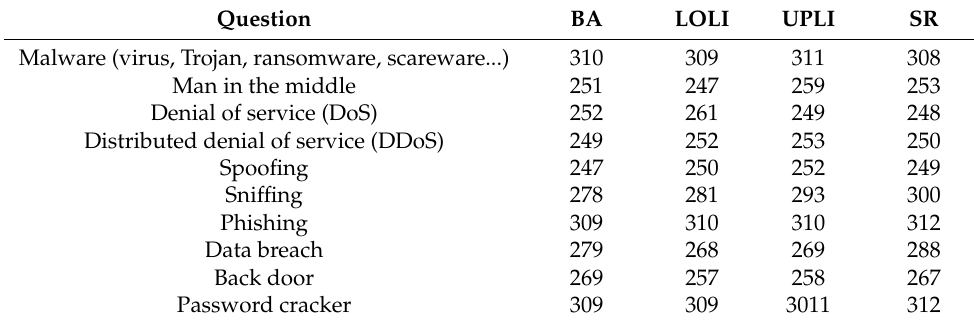
Figure 7. Level of awareness on the role of the physiotherapist on Cyb. Table 7. Results relating to the graded questions with the details of the